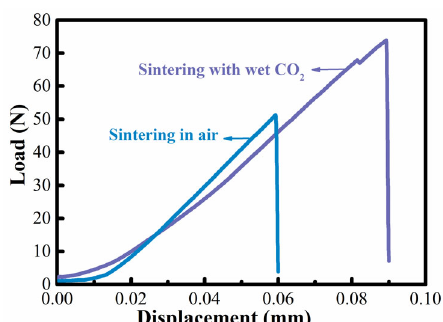
Fig. 9 Load-displacement cure for three-point bending test of HA samples sintered at 1300 with different ℃ sintering atmospheres.